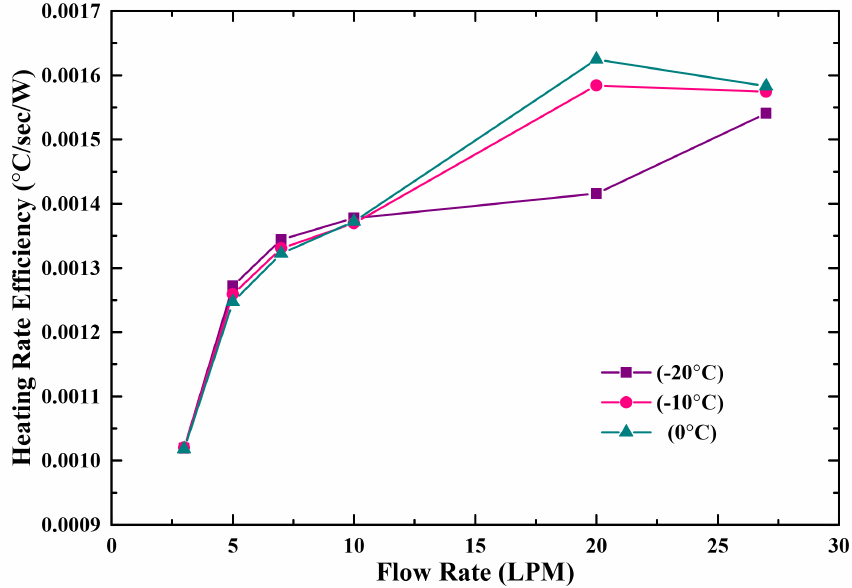
Figure 17. System overall efficiency with heater capacity: 6